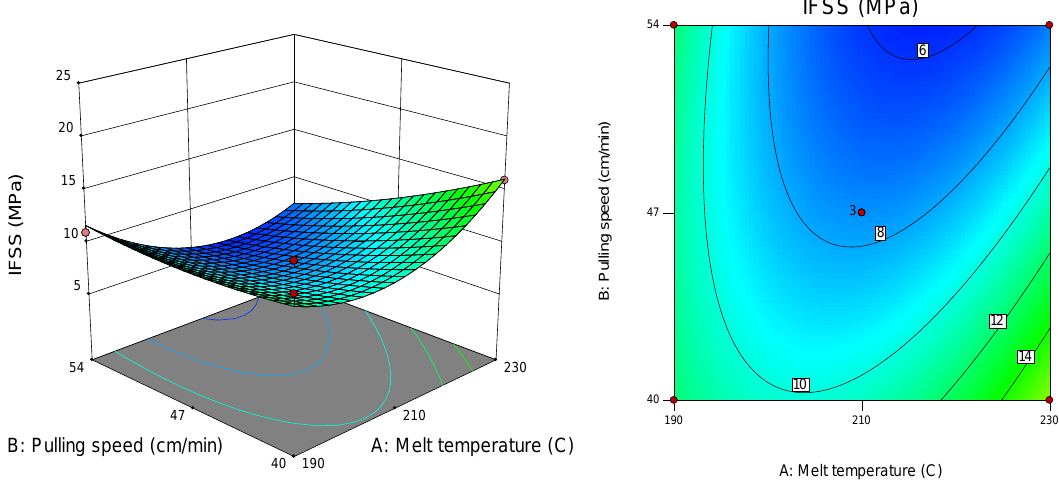
Figure 10. Surface and contour plots of IFSS versus melt temperature and pulling speed.